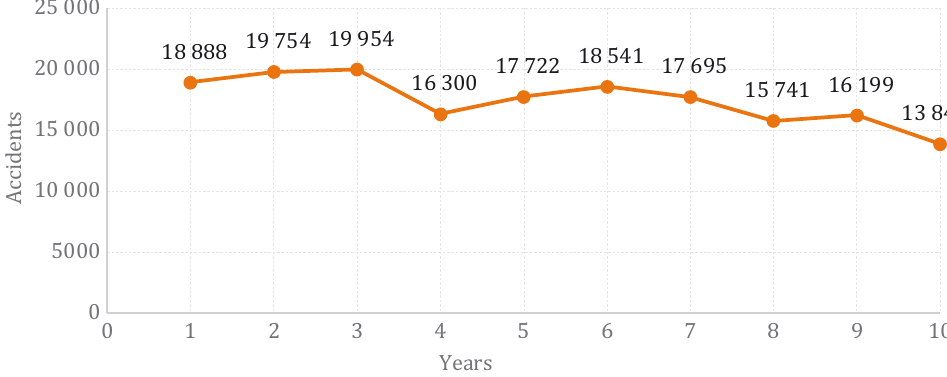
Figure 3. Road accidents in Kosovo from 2011 to